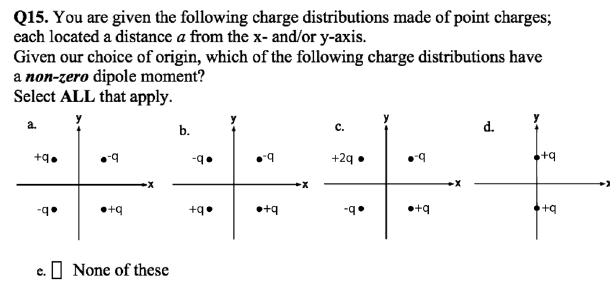
FIG. 11. Question 15 reproduced from the MC version of the CUE